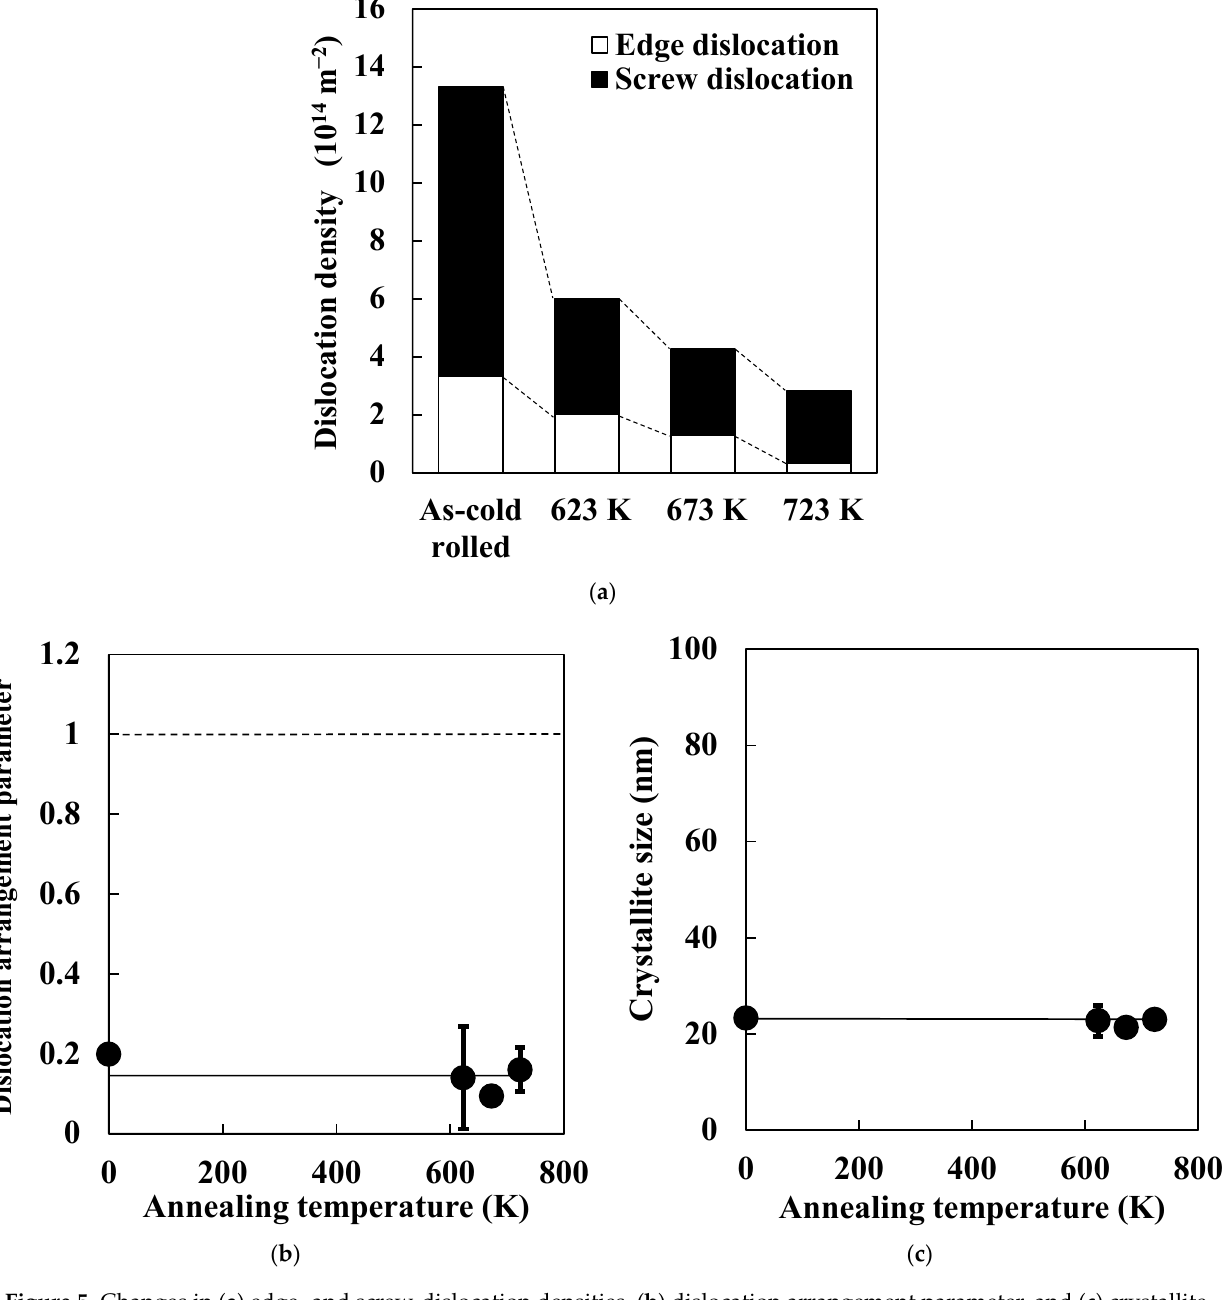
Figure 5. Changes in ( a ) edge- and screw-dislocation densities, ( b ) dislocation arrangement parameter, and ( c ) crystallite size in specimens as function of annealing temperature.